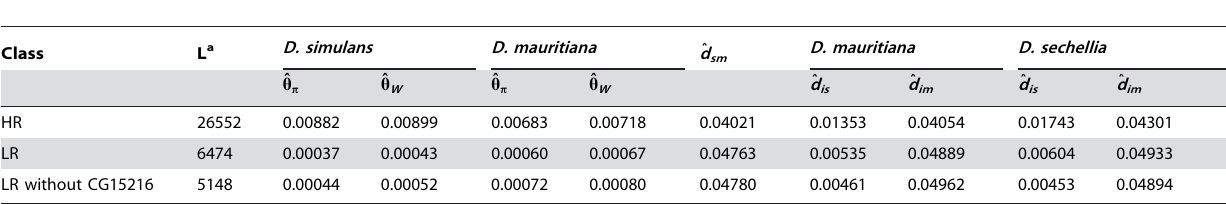
Table 3. Polymorphism and Divergence (per site) in low-recombination and high-recombination loci (unweighted average).